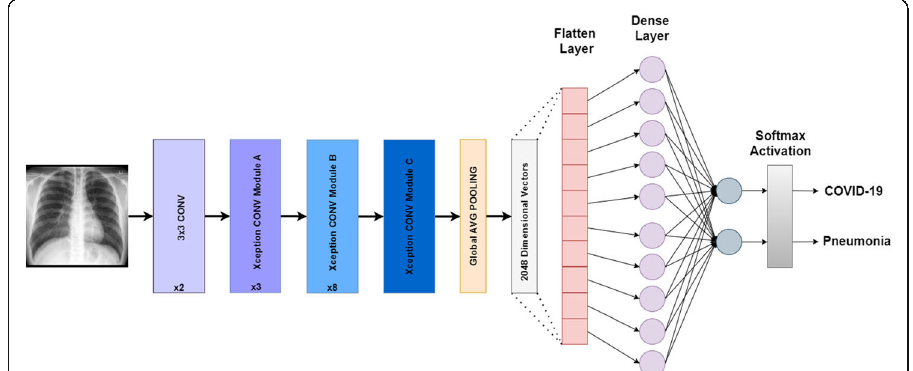
Fig. 7 Xception architecture designed for binary